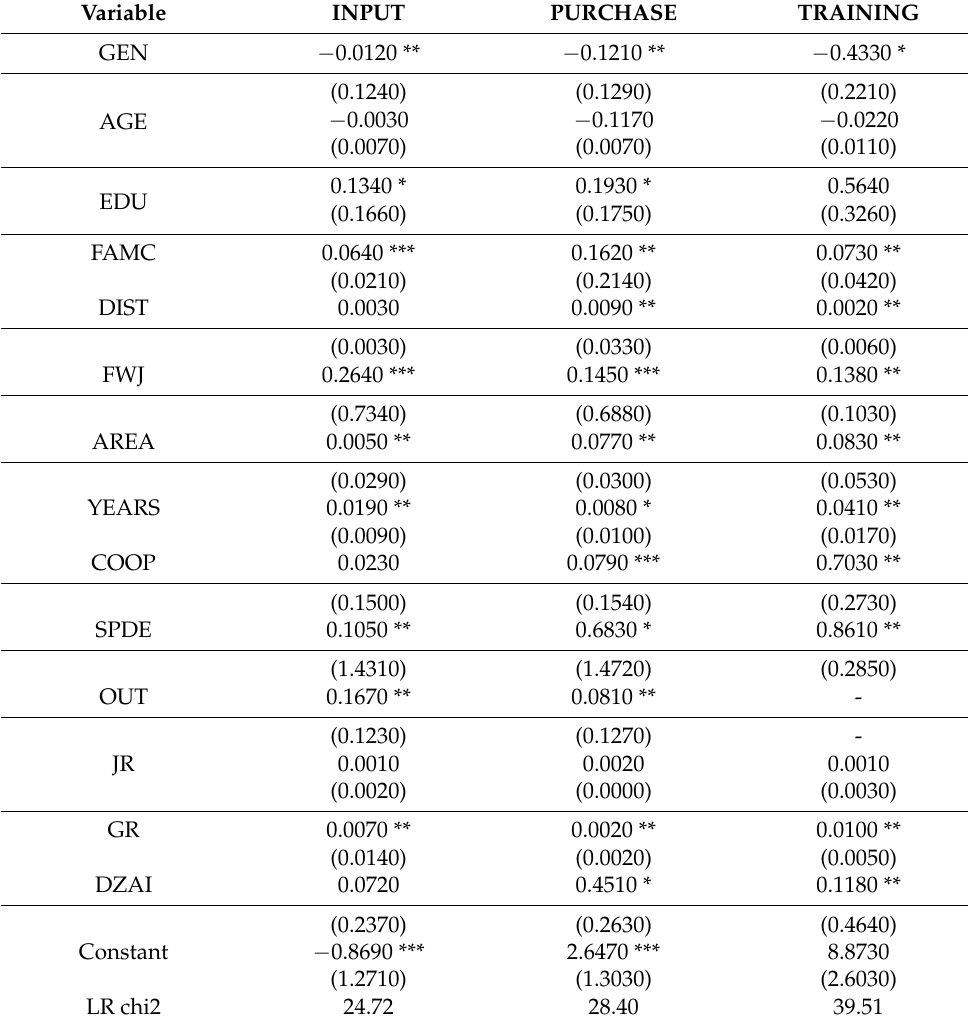
Table 2. Estimated results of decision equations of participation in the value chain based on the Probit